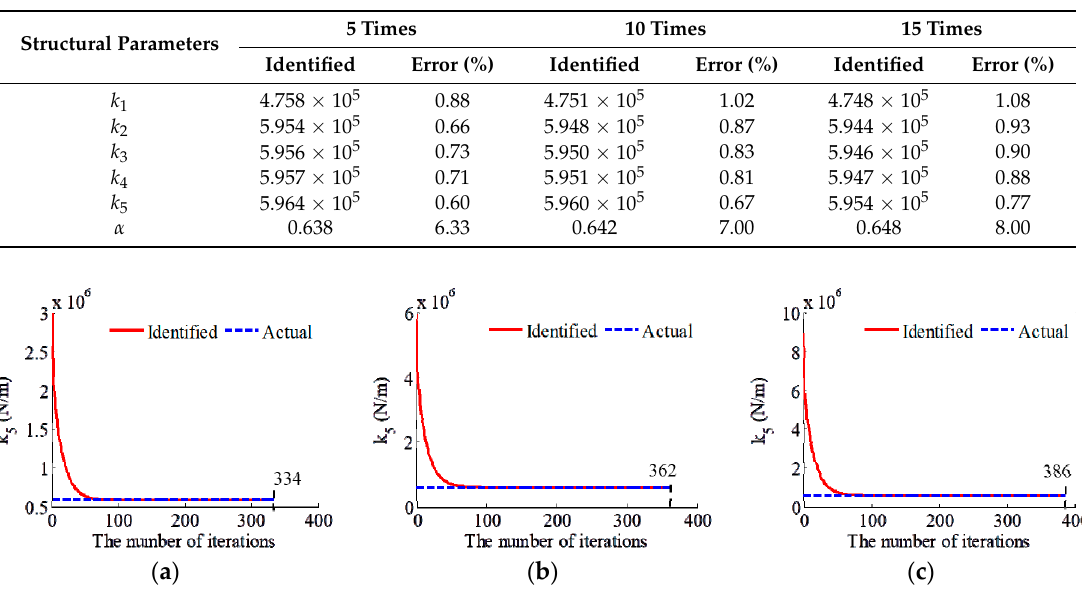
Table 3. The identified parameters with different initial values.